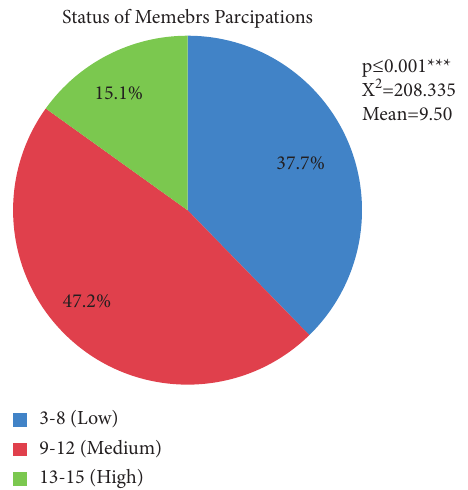
Figure 4: Participation statuses and their score ranges (source: Own survey (2020)).